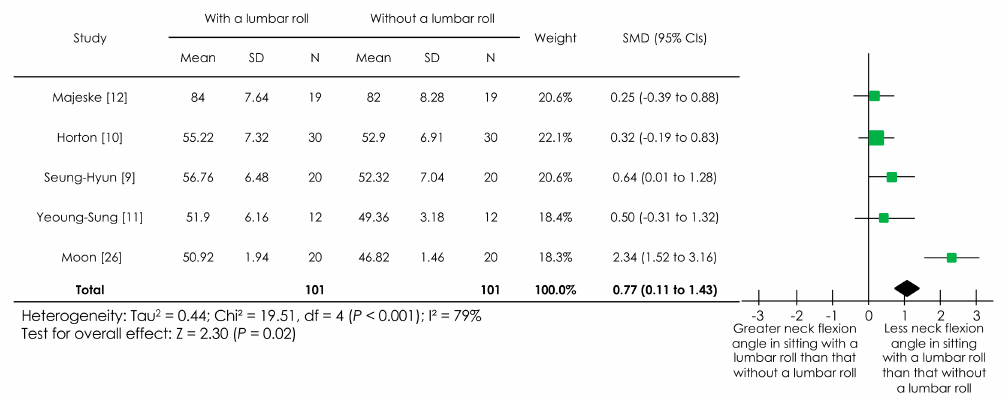
Figure 2. Forest plot of the effect of a lumbar roll in sitting on a neck angle. Abbreviations: SMD, standardized mean difference; CIs, confidence